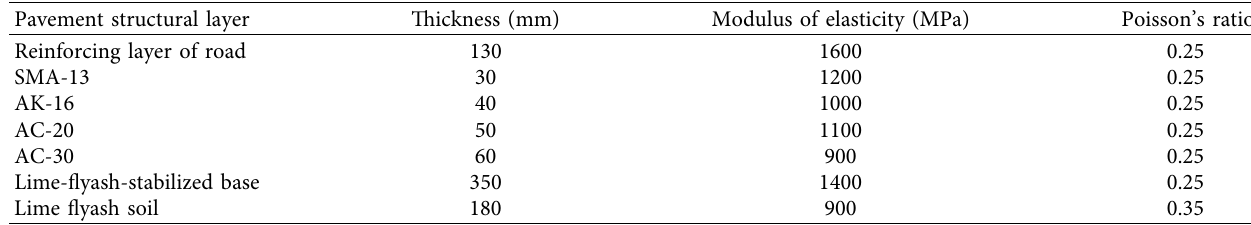
Table 3: Calculation parameters of the old pavement structure layer.